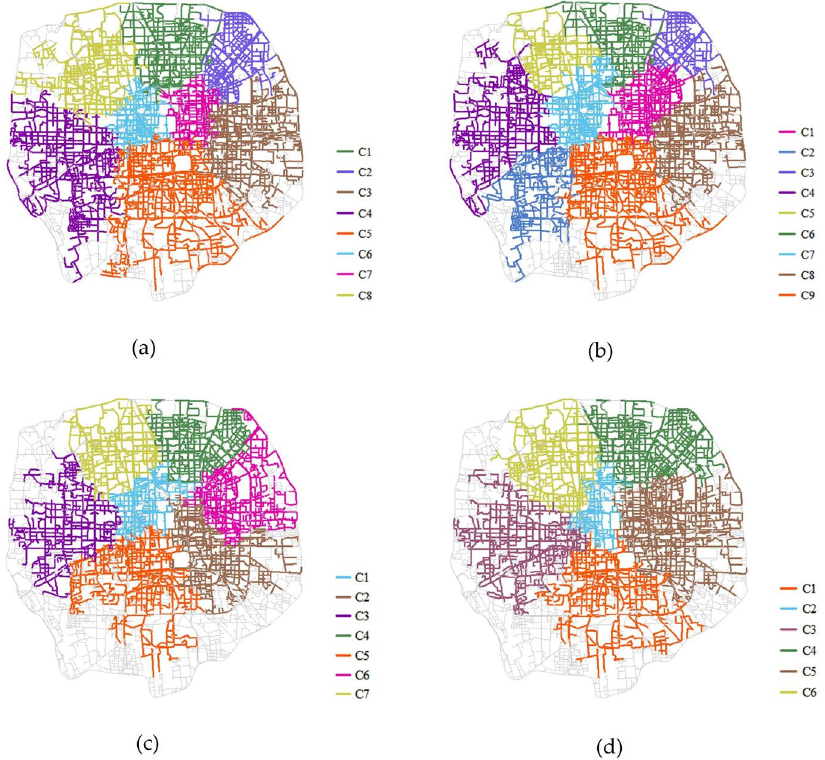
11 of 19 Figure 8. NMI with different iteration times of consensus clustering. 5.2. Spatial Communities during Morning Rush Hours Figure 9 shows the low-resolution spatial communities discovered by the proposed method and Scleiden+ during the morning rush hours on Monday and Sunday. Figure 10 shows the high-resolution spatial communities discovered by these two methods. From Figure 9, we can find that low-resolution spatial communities discovered by these two methods are similar. However, the spatial ranges of some communities identified by the two methods are different. From Figure 10, one can find that there are obviously differ-